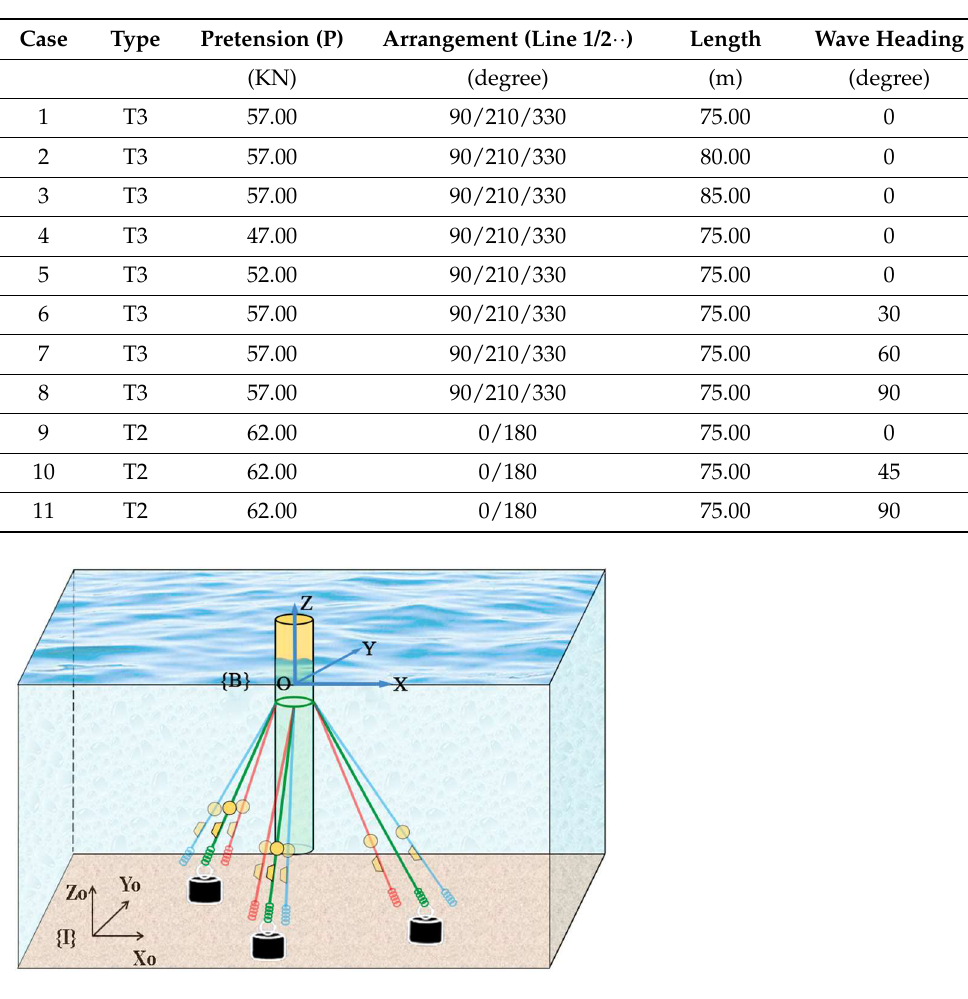
Figure 7. In-plane motions with variations in mooring length. ( a ) stiffness curve, ( b ) surge time se- ries.